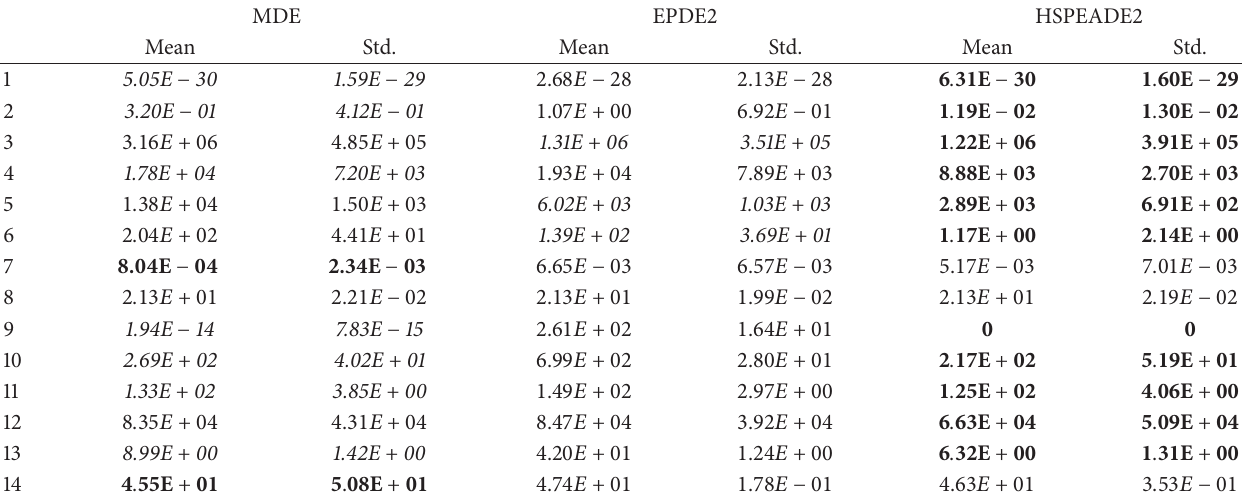
Table 6: Performance of MDE, EPDE2, and HSEPDE2 on 100D